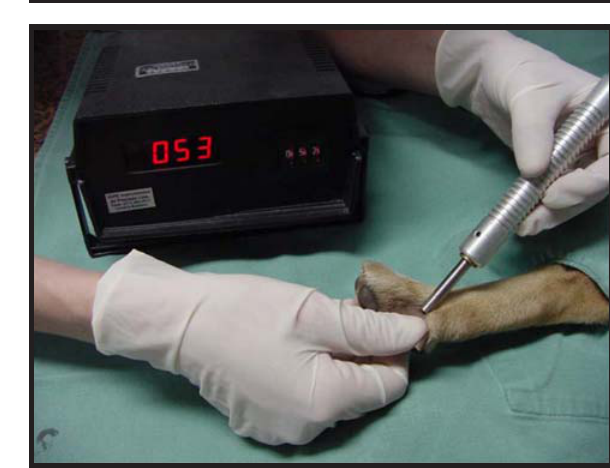
FIGURA 1 - Aplicação de pressoalgímetro na prega FIGURA 2 - Aplicação de termoalgímetro na prega interdigital do modelo experimental interdigital do modelo